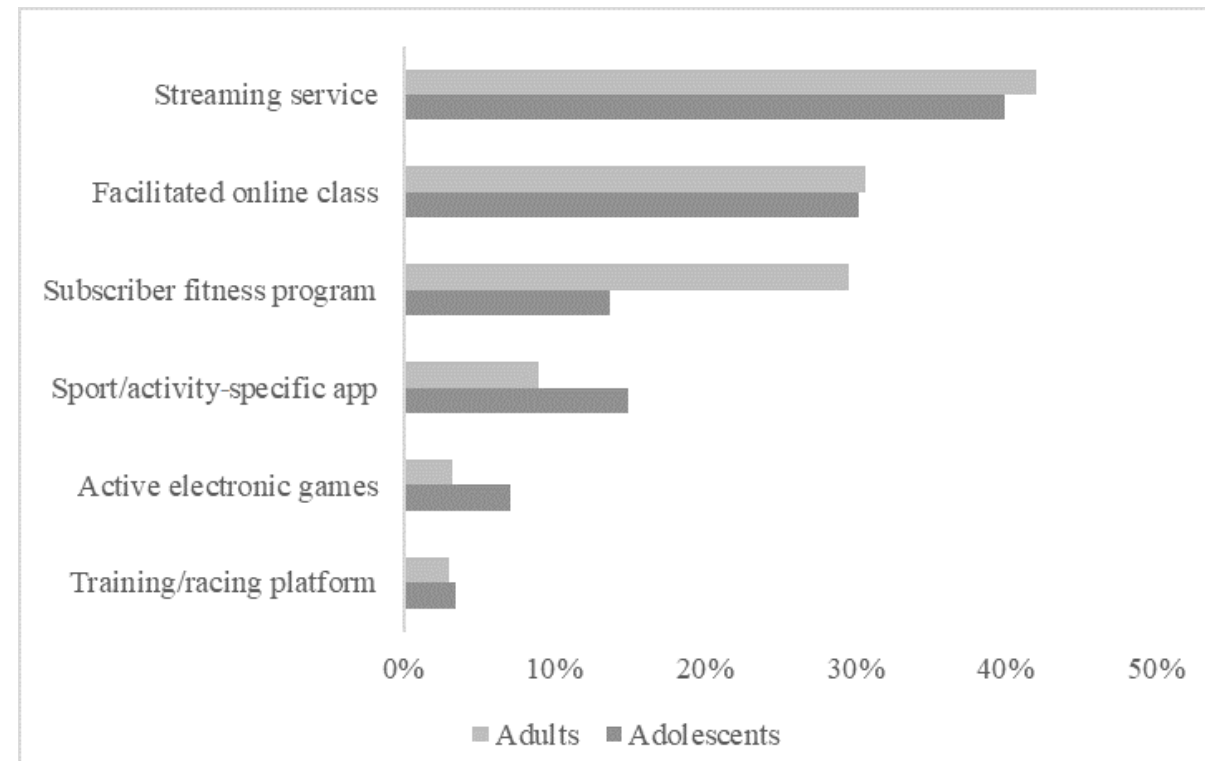
Figure 2. Use of each type of digital platform for physical activity among